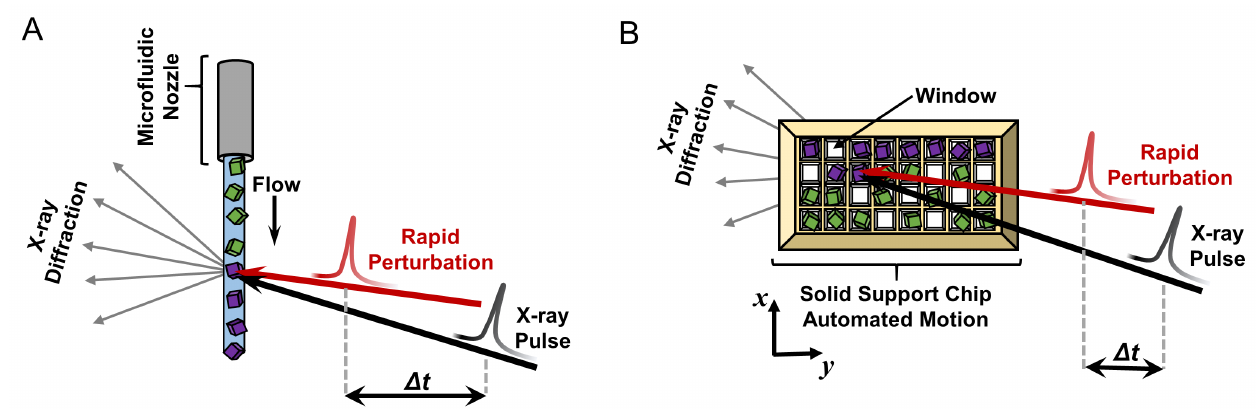
Figure 3. Sample delivery strategies for serial crystallography. In the microfluidic variety of the experiment ( A ), crystals are delivered to the X-ray beam using a microfluidic nozzle ranging from tens to hundreds of microns in diameter. A stream of randomly oriented microcrystals continuously flows perpendicular to the pulsing X-ray beam (black arrow). In the fixed-target version ( B ), microcrystals are mounted (by pipetting) in random orientations on a solid support chip that contains appropriately sized windows, and the chip is rapidly moved through the pulsing X-ray beam (black arrow) by automated translation in the x and y directions. In both diagrams, each crystal yields a single diffraction pattern capturing a random slice of reciprocal space. Crystals that have not been probed by the X-ray beam are colored green, and those that have been measured, and destroyed, are depicted in purple. In time-resolved serial crystallography, a perturbation (shown by the red arrow) is applied to the crystals with user-defined timing prior to the X-ray pulse ( Δ t ). This figure is an original image created by the authors for this